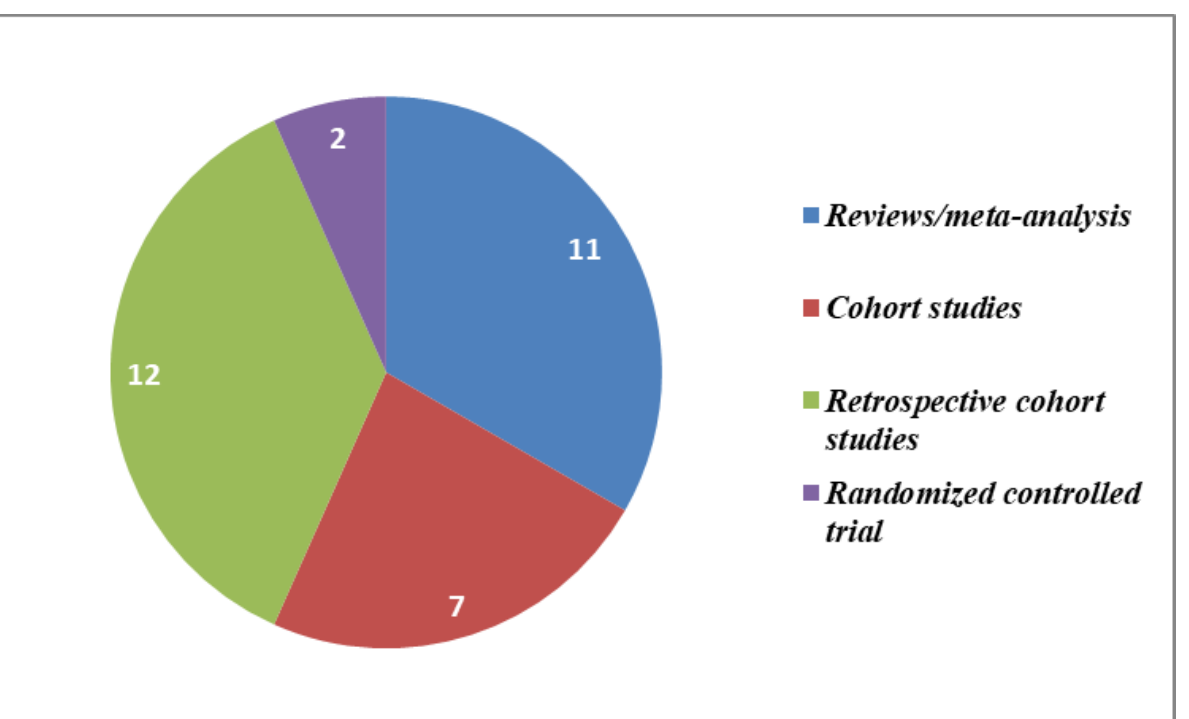
Figure 1. Studies distribution according to type of publication.